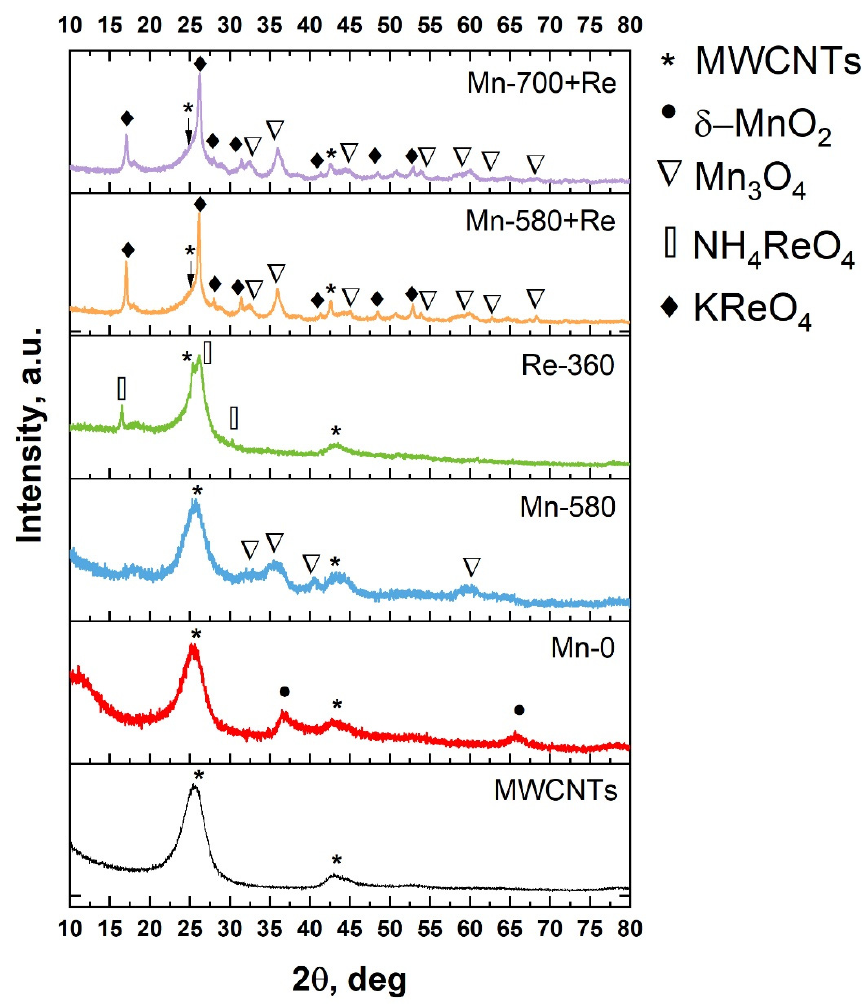
Figure 2. XRD patterns for MWCNTs and composites based on them.